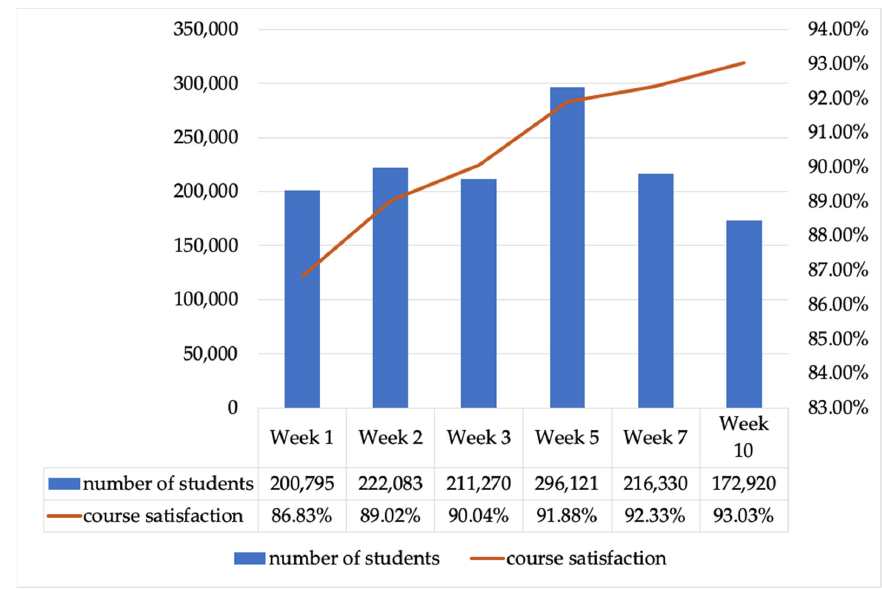
Figure 3. Student perception of the BL courses during the school closure period.